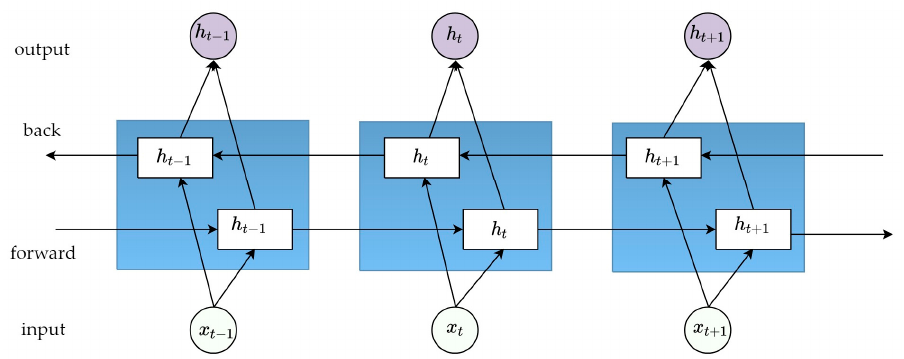
Figure 5. The network structure of BiLSTM.